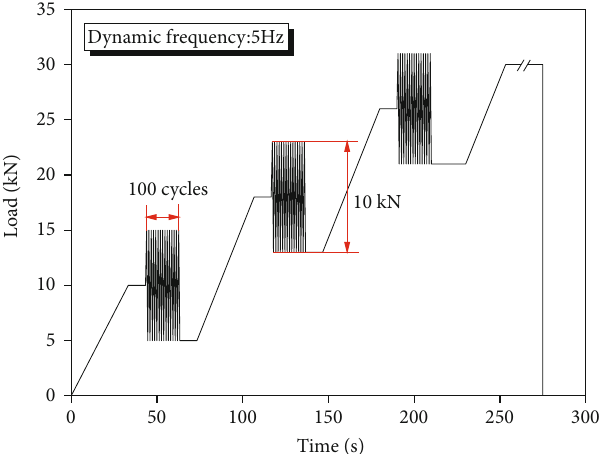
Figure 3: Test loading paths under coupled static and dynamic loads.